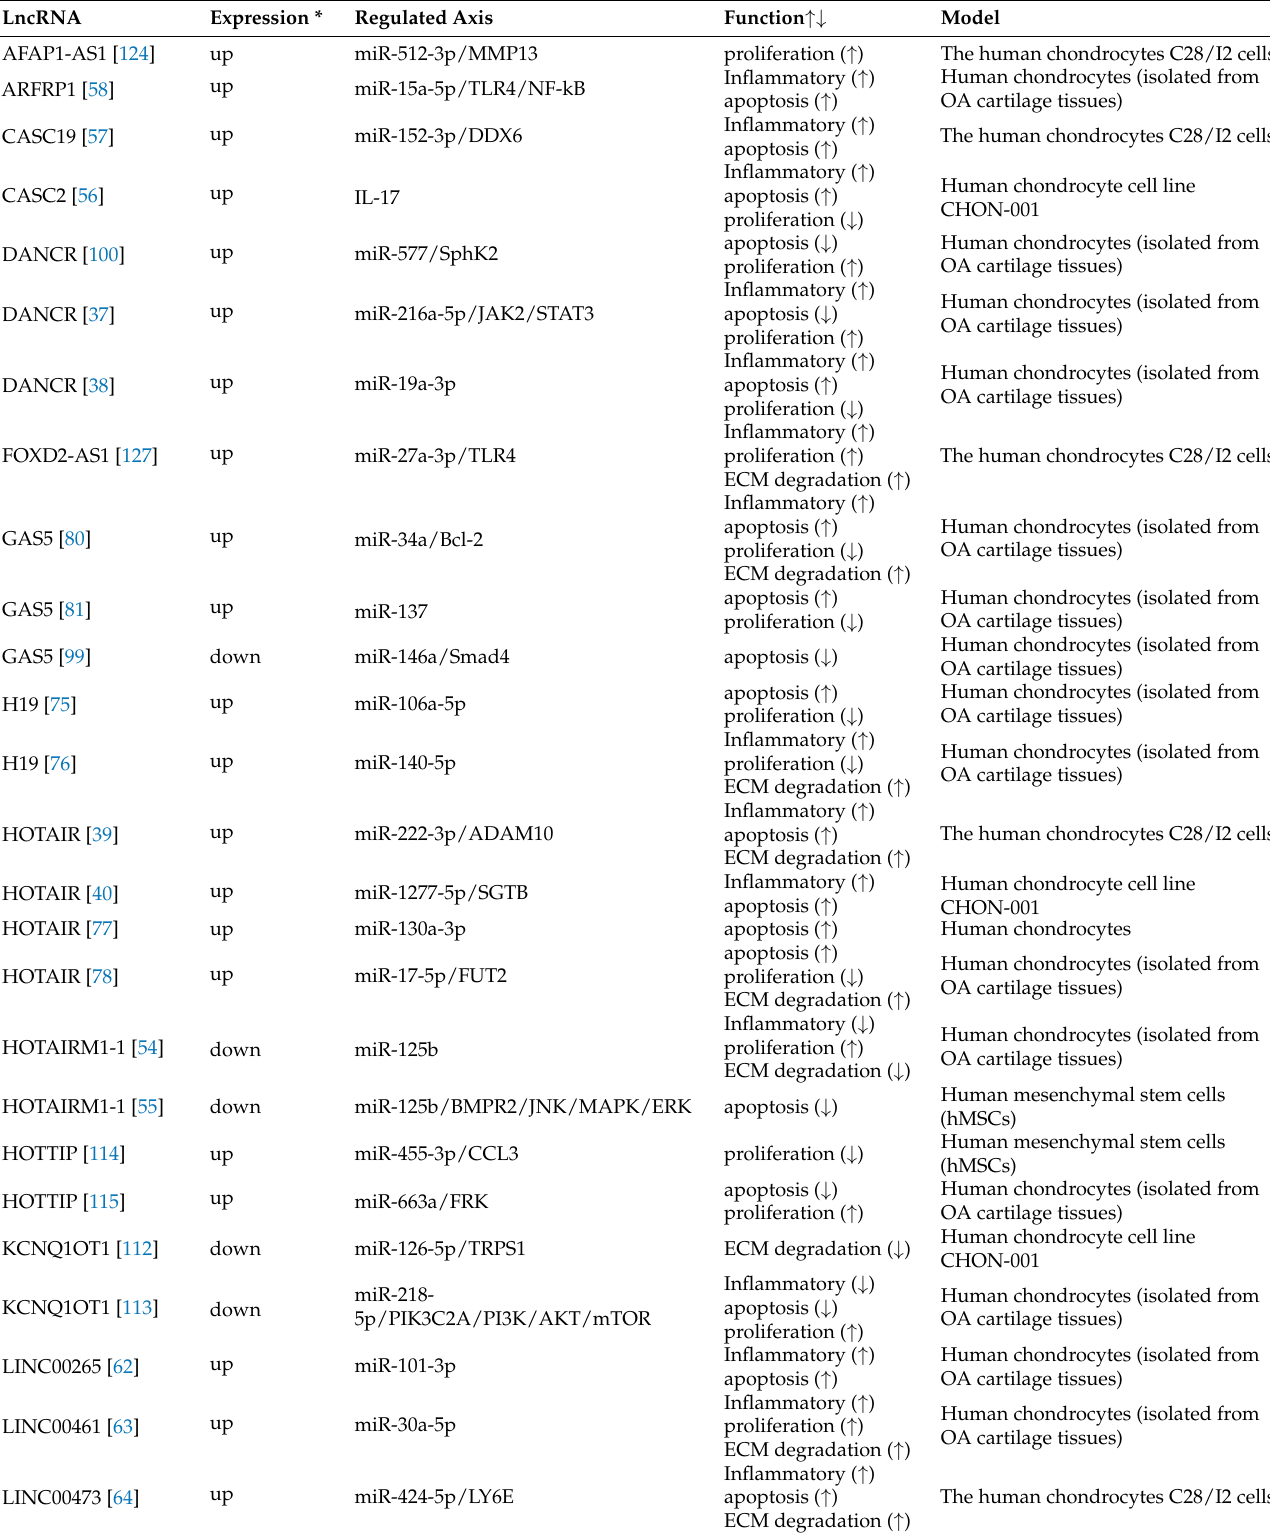
Table 2. Abnormal expression and function of lncRNAs in osteoarthritis cartilage described in this review (human